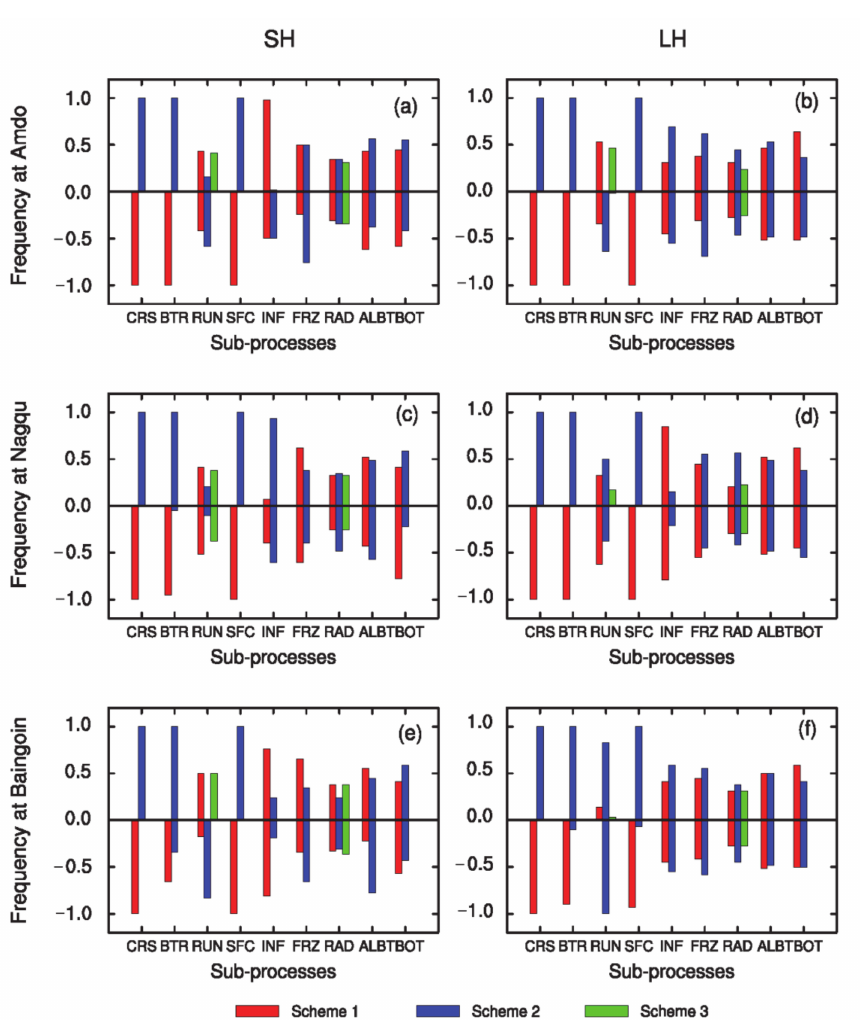
Figure 7. The selected frequency of di ff erent schemes of each subprocess for (left panel) SH and (right panel) LH in the best members (0–1) or worst members ( − 1–0) at the ( a , b ) Amdo, ( c , d ) Nagqu, and ( e , f ) Baingoin sites in ensemble experiment Ens2 when the AWS precipitation is